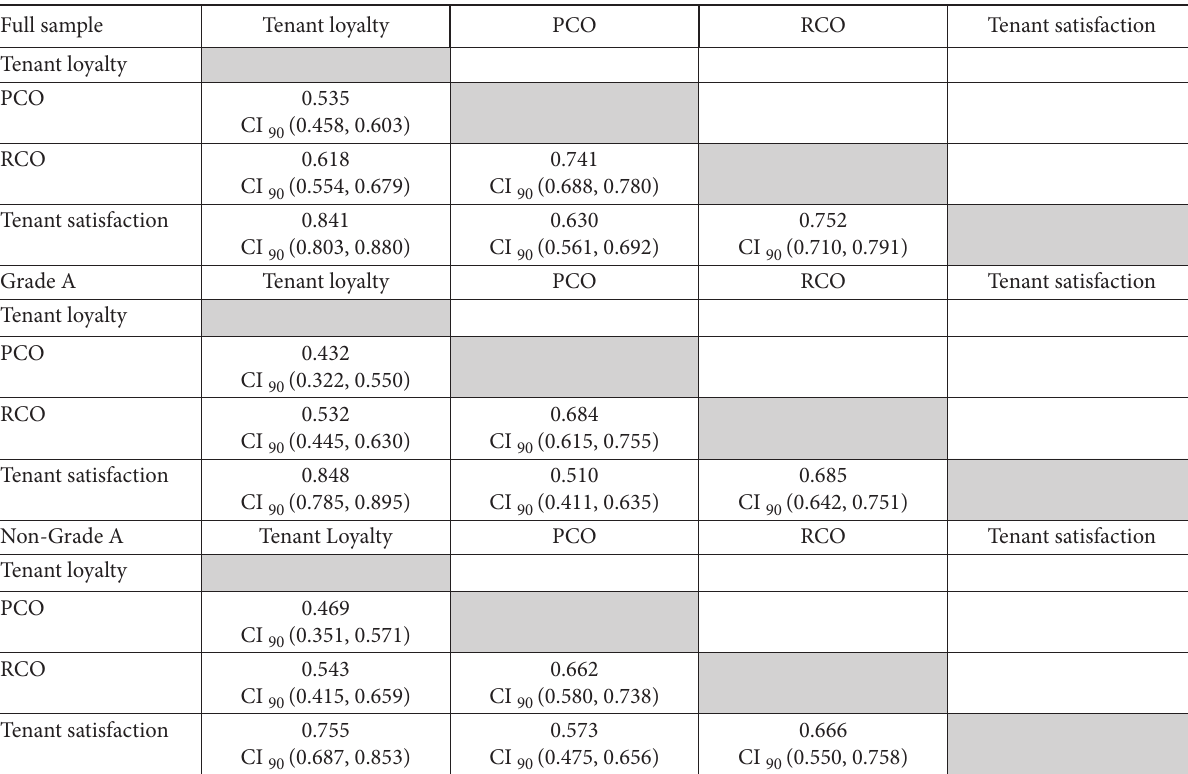
Table 3. Discriminant